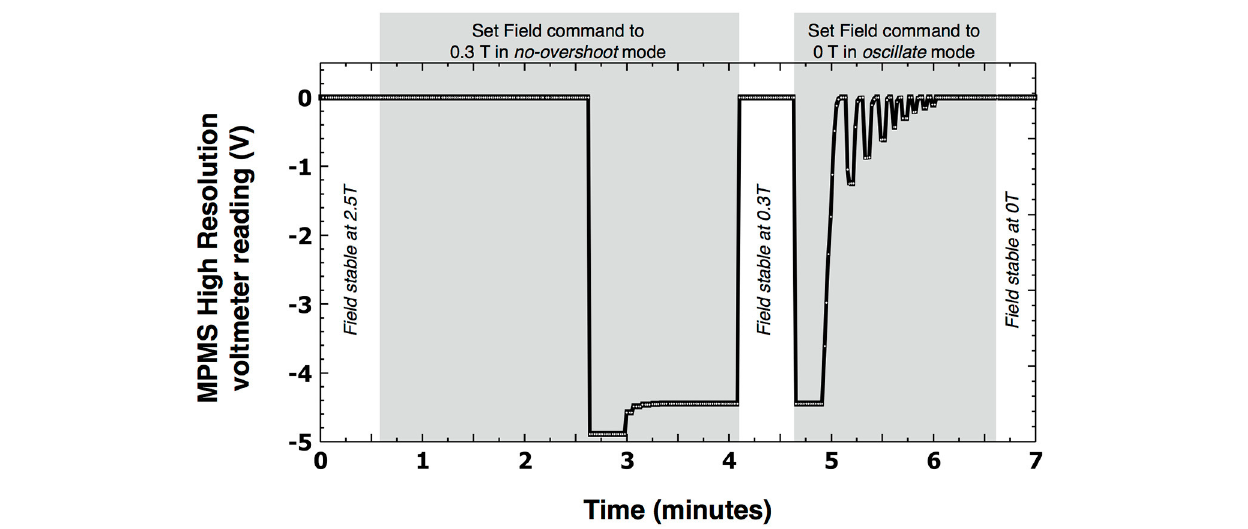
FIGURE 1 | The charging and discharging of the supraconducting magnet differs whether the target magnetic field is approached using the no-overshoot or oscillation modes. The difference can be monitored through the MPMS high-resolution voltmeter readings. The gray boxes delimit the time elapsed from the moment the set field command is activated to the moment the software alerts the set magnetic field is stable. Reducing a stable magnetic field of 2.5–0.3 T using the no-overshoot mode takes approximately three and a half minutes. Reducing a stable magnetic field of 0.3–0 T using the oscillate mode takes approximately 2 min. Manipulating the magnetic field as shown in the figure leads to the 300 mT peak field demagnetization of a 2.5 T IRM that can be acquired at any temperature between 2 and 400